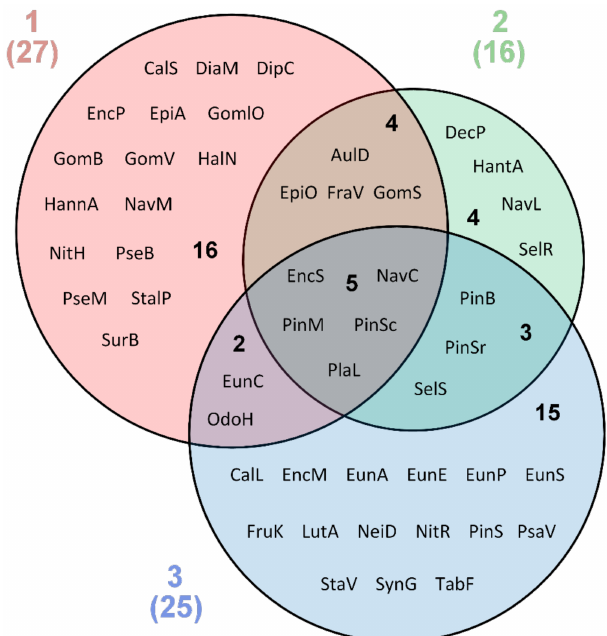
Figure 4. The similarities between diatom communities from the thermal springs studied. 1 (pink circle)—Malki hot springs community, 2 (green circle)—Upper Paratunka thermal springs, 3 (blue circle)—Dachnie thermal springs. Numbers in brackets indicates the numbers of species in